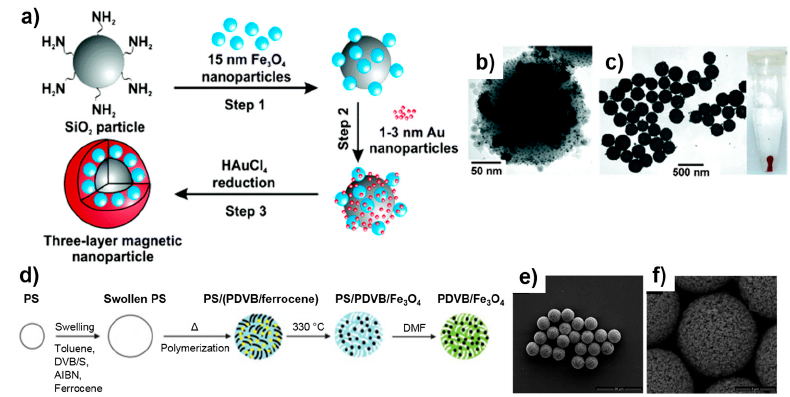
Figure 3. Examples of preparation methods for MPs embedded in silica and polymer matrices: ( a ) layer-by-layer synthesis of gold-coated silica-core MPs, ( b ) TEM image of SiO 2 @ Fe 3 O 4 @ Au seeds , ( c ) MPs attracted to the vessel wall by a magnet, ( d ) preparation of polymer composite magnetic particles by the swelling method, and ( e , f ) SEM image of polymer-embedded MPs. Reproduced with permissions from [72], copyright 2005 American Chemical Society, and from [73], copyright 2012 Royal Society of